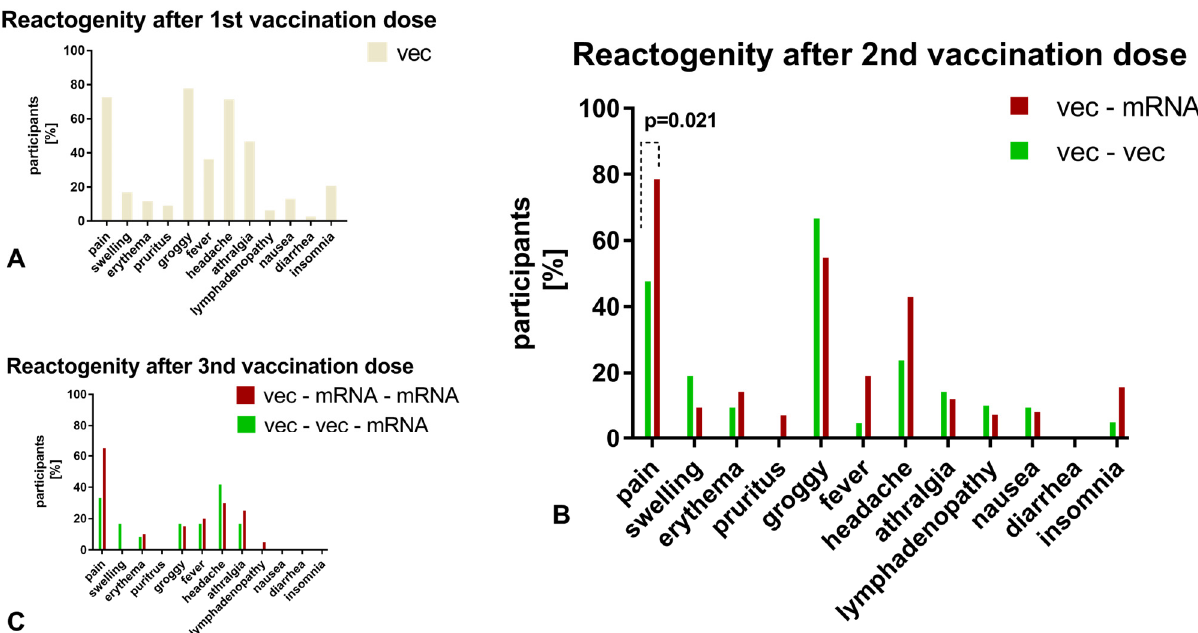
Figure 6. ( A ): For the first vaccination, only symptoms after the vector-based immunization are illus- trated due to a small number of mRNA-vaccinated participants. ( B , C ): Depending on the vaccination scheme (homologous versus heterologous), the vaccination reactions are compared after the second vaccination. Only significant differences are indicated by a p -value. Vector–vector/+mRNA cohort: green, vector–mRNA/+mRNA cohort: